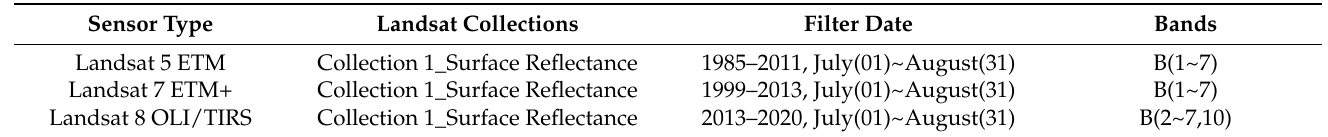
Table 1. Landsat data source.